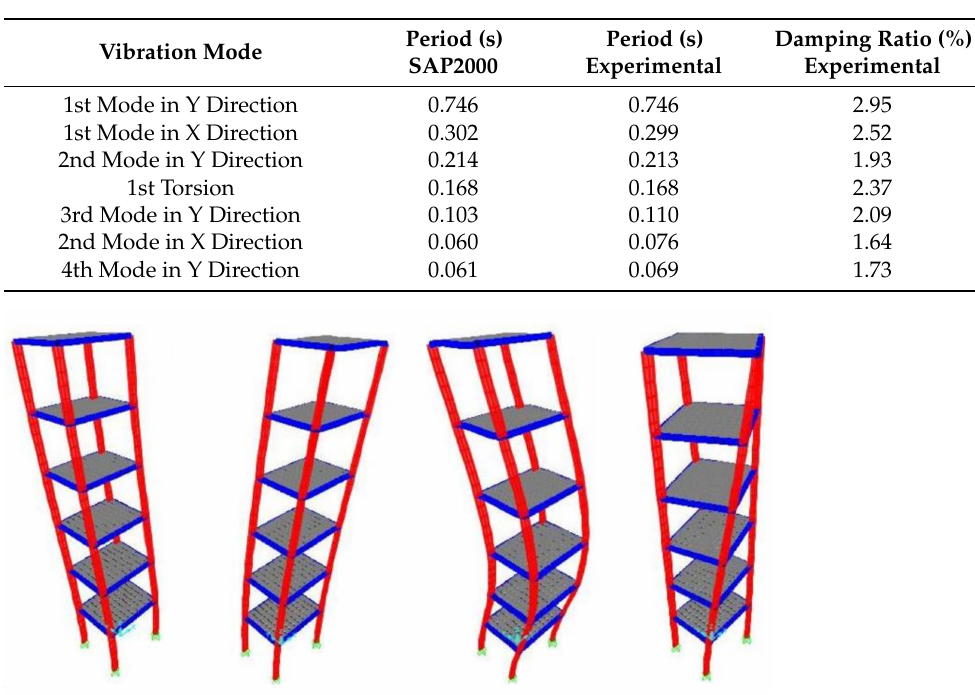
Table 3. Dynamic properties calculated for the test model.